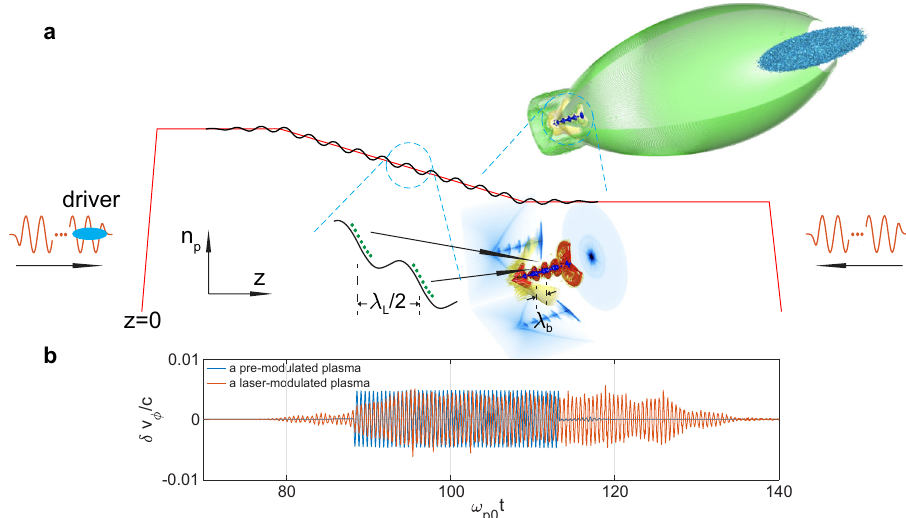
Fig. 1 The concept of bunched beam generation from density downramp injection in PBA (not to scale). a A plasma with a density downramp (red line) is set at t = 0. Two linearly polarized laser pulses propagate from the two ends of the plasma towards its center and their overlap creates a density modulation with period λ L /2 (black line). A properly delayed electron beam driver is incident on the plasma from the left to excite a blowout wake (as shown in the upper inset) and inject electrons only at half of the density modulation period (green dots) and they are mapped to discrete axial positions with period λ b after injection (as shown in the lower inset). b The modulation of the phase velocity of position E z = 0 with k p0 ξ ≈